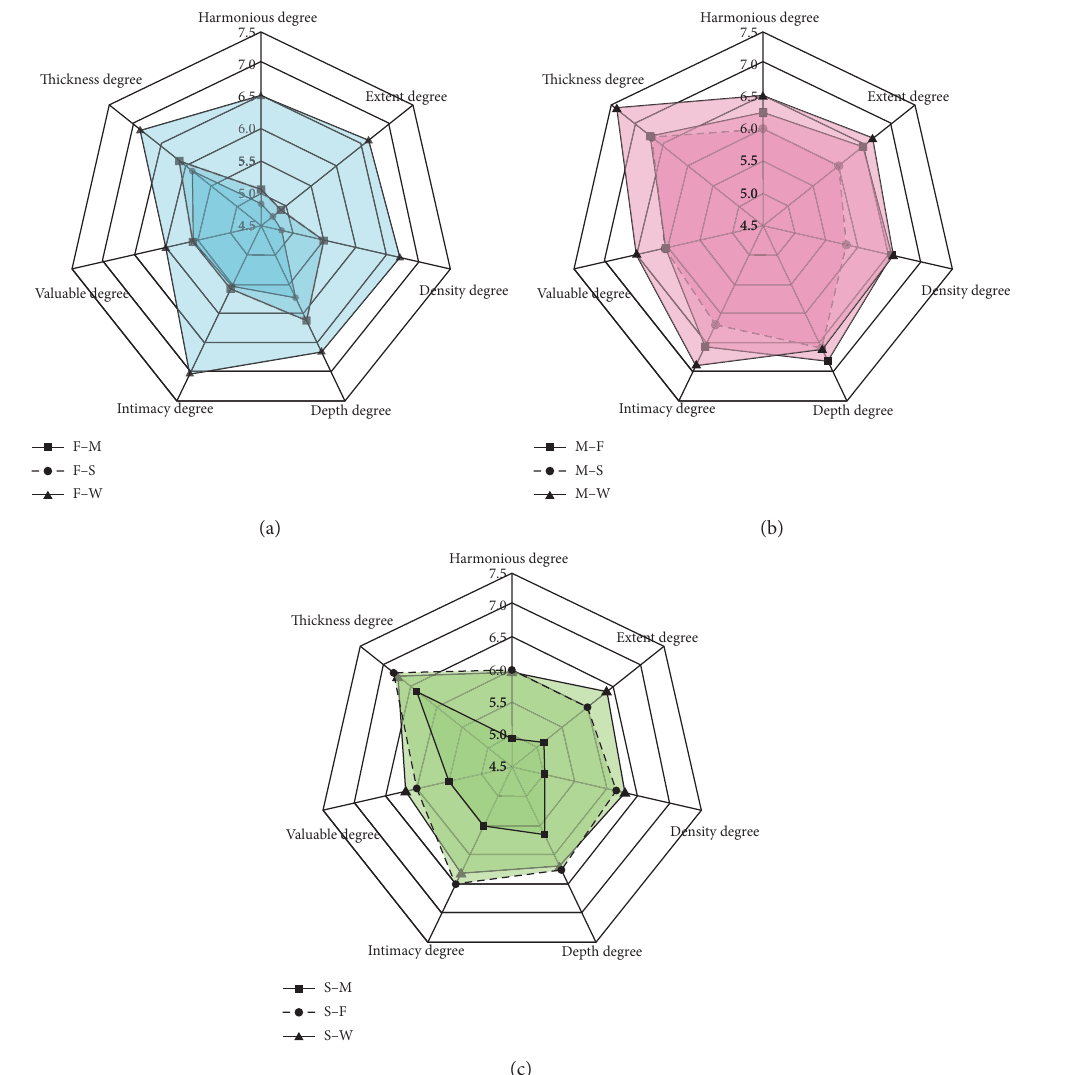
Figure 2: A subitems radar chart of the same role’s relationship perception with other multiple roles: (a) frontline miners, (b) managers, (c) supervisors.